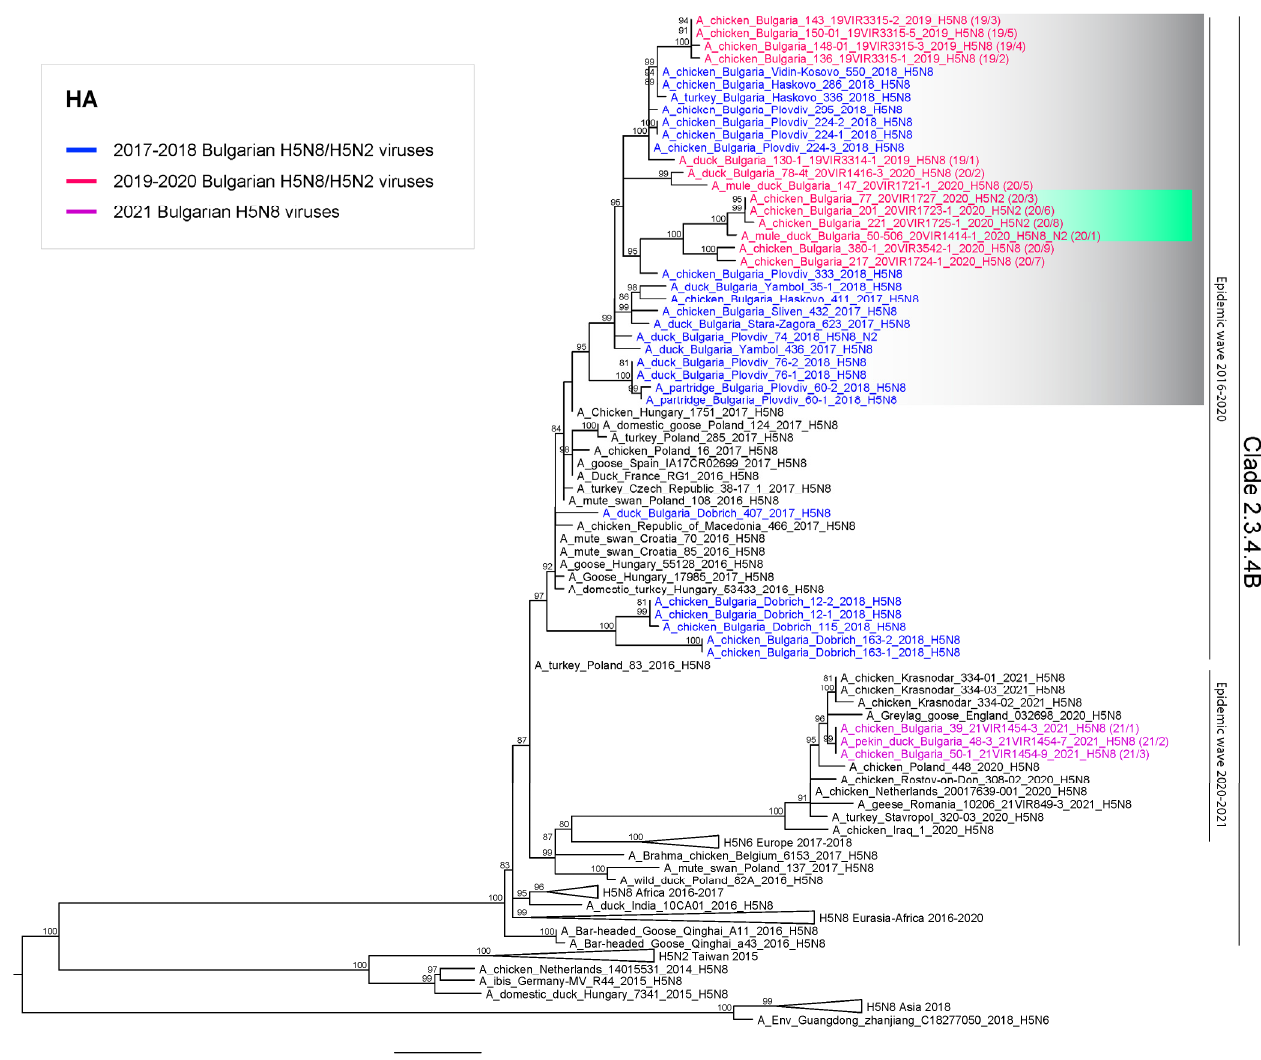
Figure 1. Maximum Likelihood phylogenetic tree of the HA gene (clade 2.3.4.4B). The tree was inferred using IQTREE v1.6.6. The grey box shows the cluster of Bulgarian H5 (N8 and N2) viruses identified in 2019–2020 together with some previously reported 2018 H5N8-H5N2 detections; the light green box shows the cluster of 2020 Bulgarian H5N2 viruses. The viruses are colored according to the years of collection. Ultrafast bootstrap supports higher than 80 are indicated next to the nodes.